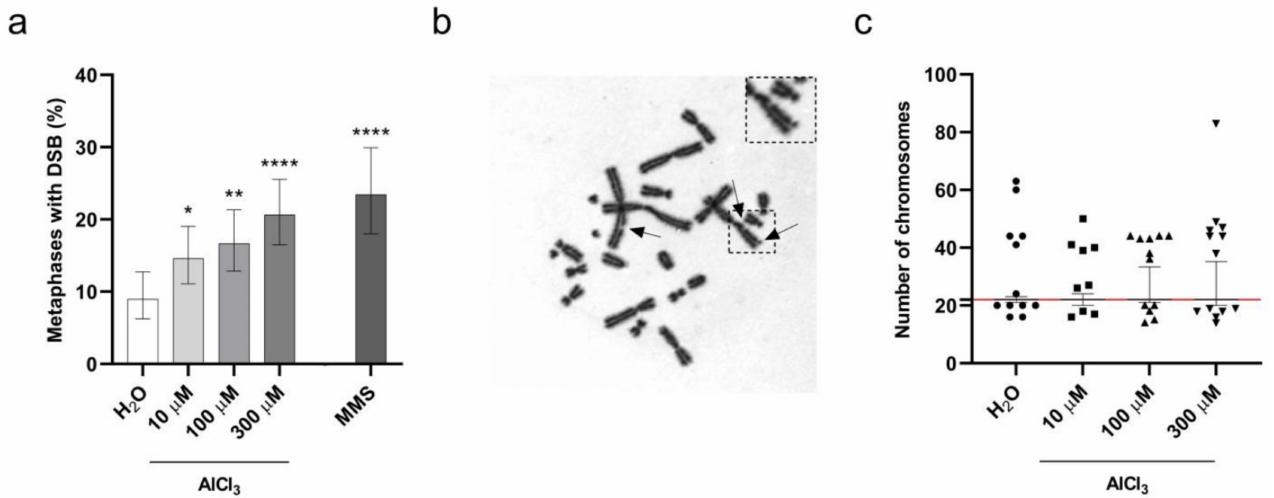
Figure 4. Aluminum induces DSB and aneuploidy in V79 cells. ( a ) Dose-dependent increase in DSB in V79 cells exposed for 24 h (1 h in serum-free medium followed by 23 h with 1% FCS addition without medium change) to the indicated concentrations of AlCl 3 , or the same volume of H 2 O. Parallel treatment with 60 µ g/mL MMS for 3 h in serum-free medium followed by 21 h in standard medium was used as positive control. Bars represent the mean percentage ± the Wilson–Brown 95% Confidence Interval. Total number of metaphases analyzed in three independent experiments: H 2 O 301, AlCl 3 10 µ M 301, AlCl 3 100 µ M 294, AlCl 3 300 µ M 305, MMS 192. (*) p -value < 0.05; (**) p -value < 0.01; (****) p -value < 0.0001 (Logistic regression). ( b ) Representative Giemsa stained metaphase of V79 cells exposed for 24 h to 300 µ M AlCl 3 as detailed in ( a ). Arrows indicate chromatid breaks. ( c ) Distribution of the number of chromosomes in metaphases of V79 cells exposed for 24 h to the indicated concentrations of AlCl 3 , or the same volume of H 2 O, as detailed in ( a ). The graph shows the median and the percentile range between the 2.5 and the 97.5 percentiles of the number of chromosomes in metaphases. Symbols indicate outlier chromosome number values below the 2.5 or above the 97.5 percentiles. The red line indicates the normal number of chromosomes (22) in a V79 cell. Total number of metaphases analyzed in three independent experiments: H 2 O 299, AlCl 3 10 µ M 293, AlCl 3 100 µ M 292 and AlCl 3 300 µ M